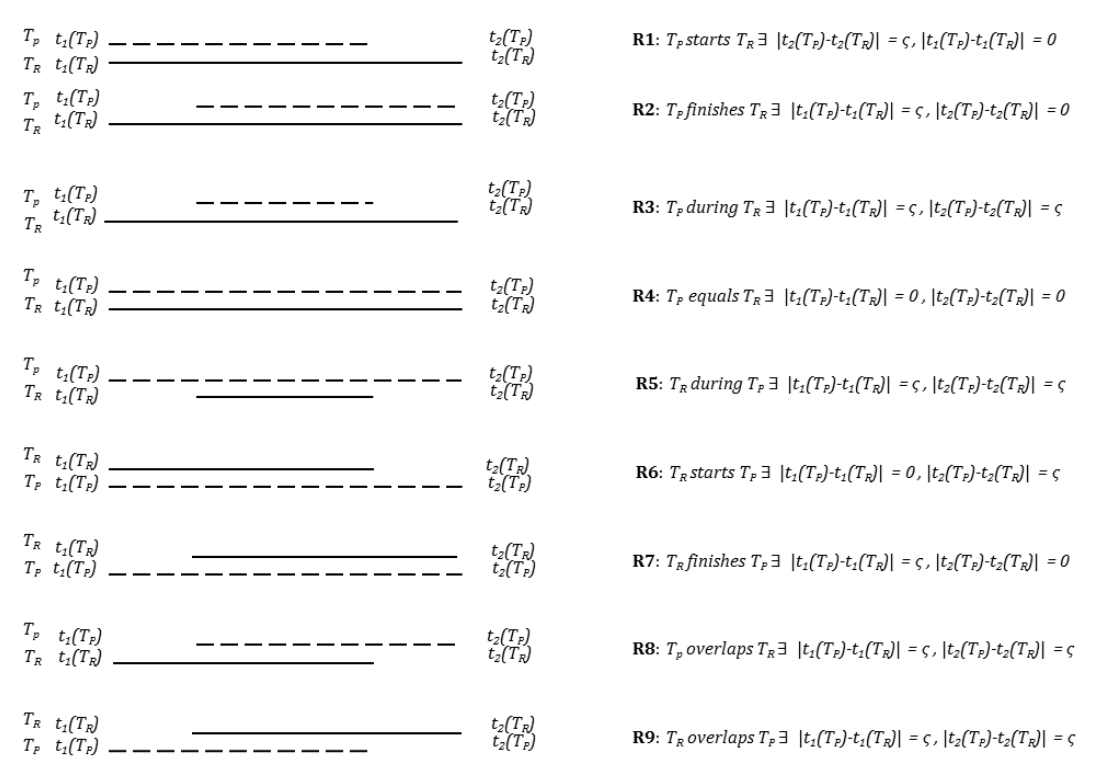
Figure 1. Trip uncertain temporal relationships between a reported trip ( T R ) and predicted trip ( T P ) based on Allen’s temporal calculus. In this figure t 1 and t 2 are the start time and end time of a given trip